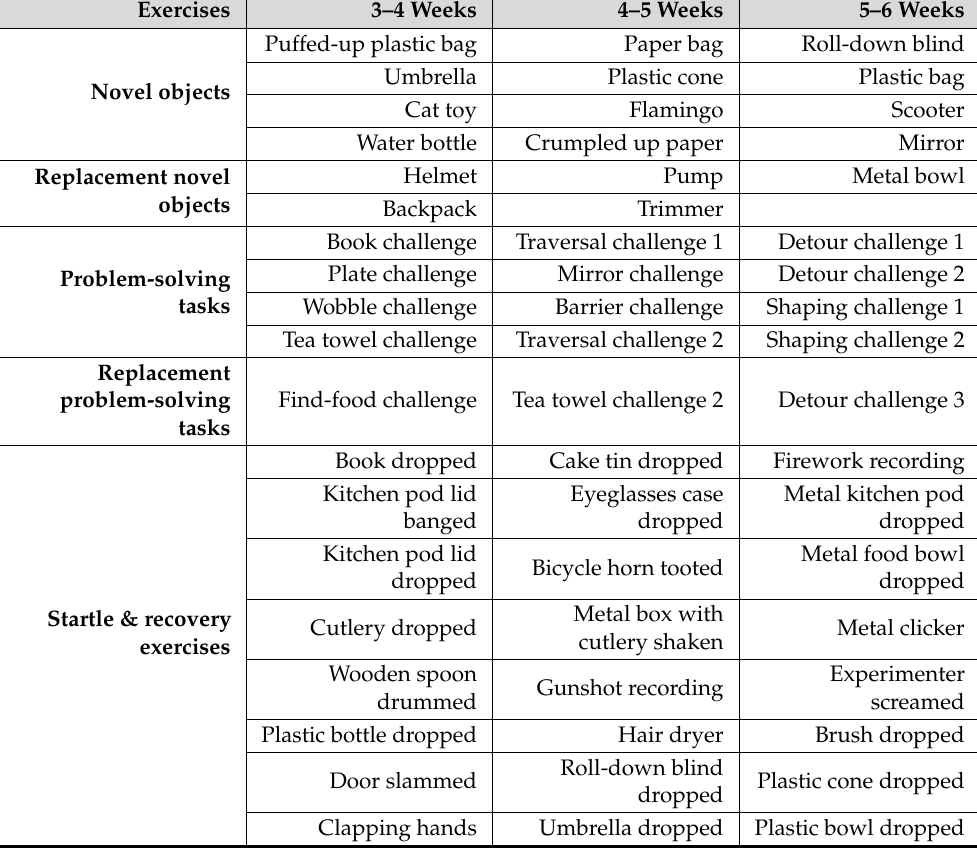
Table 1. Selection of exercises presented in each week during the three-week treatment phase (a total of 12 sessions per dog). Each session included presentation of a novel object (while puppies were inside the pen), a problem-solving task (easier tasks were presented first), and two different sounds. If a litter was already familiar with a given object, a “replacement novel object” or “replacement problem-solving task” was presented instead.